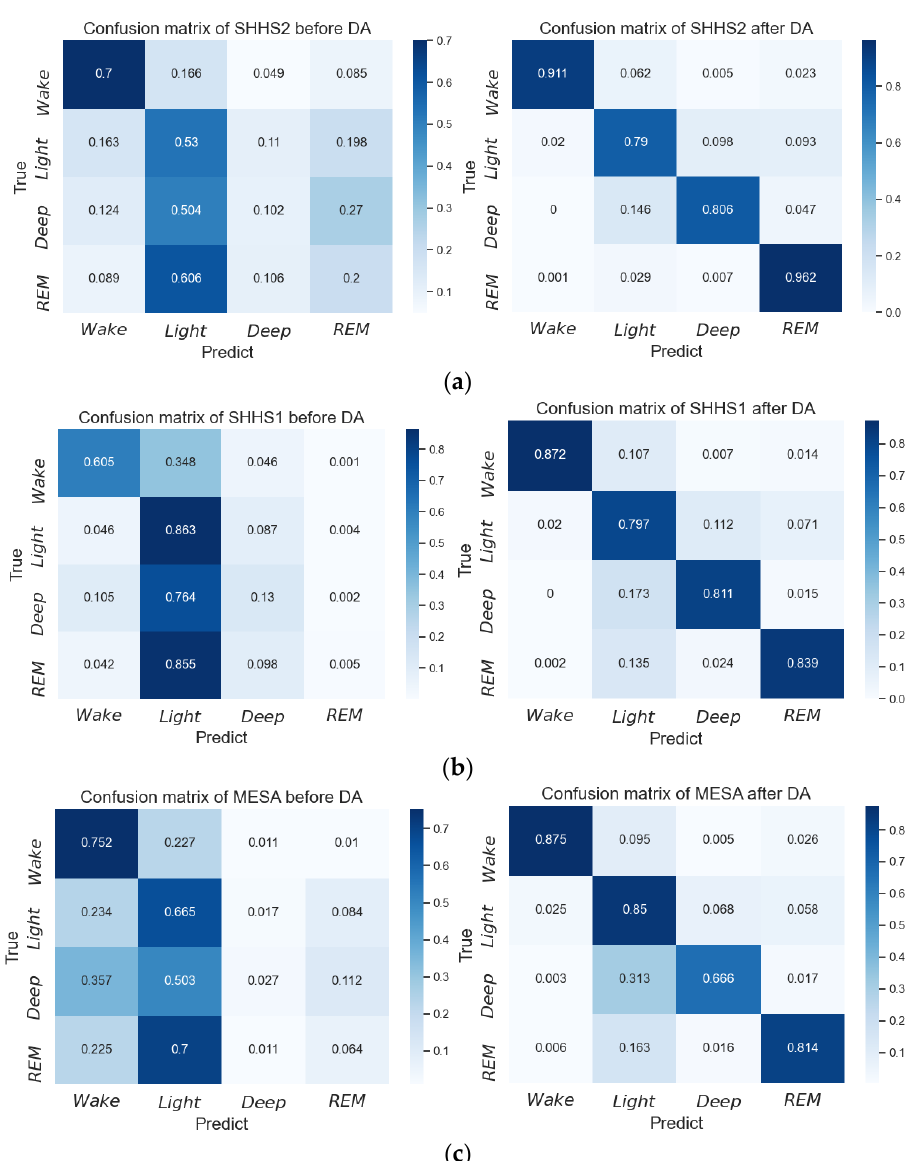
Figure 6. Confusion matrix of inter-subject sleep staging before and after domain adaptation based on the proposed network. ( a ) Confusion matrix for SHHS2, ( b ) confusion matrix for SHHS1, and ( c ) confusion matrix for MESA.